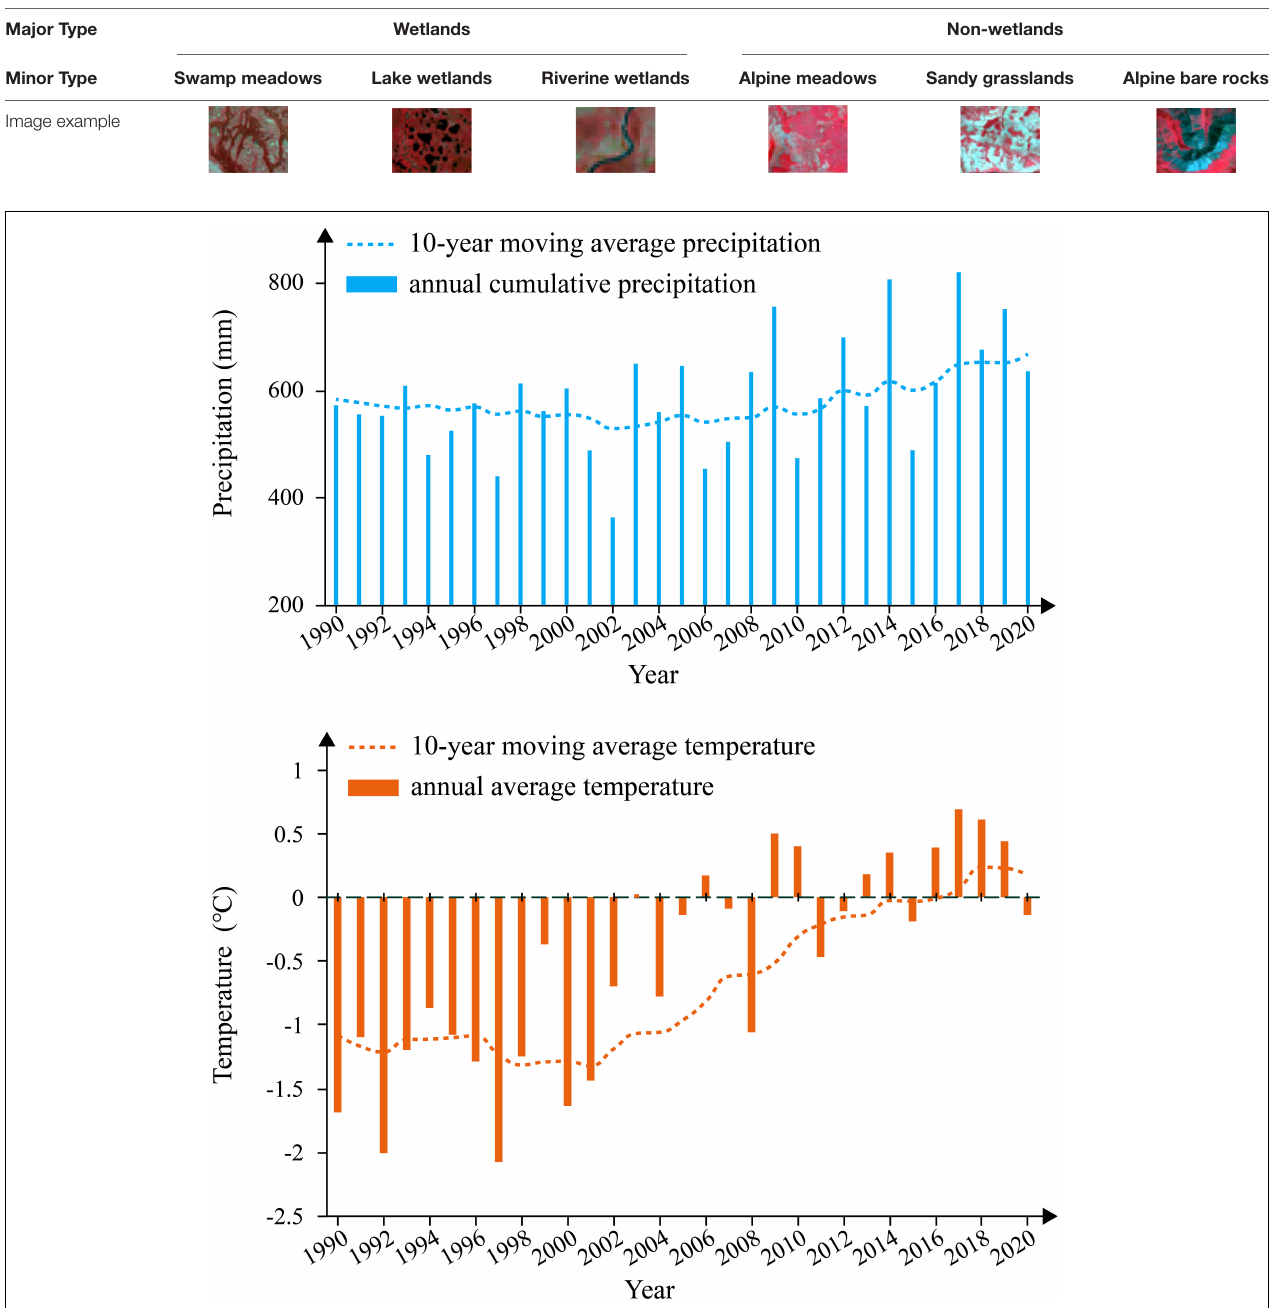
FIGURE 2 | Trends of temperature and precipitation at the Shiqu County Weather Station from 1990 to 2020.